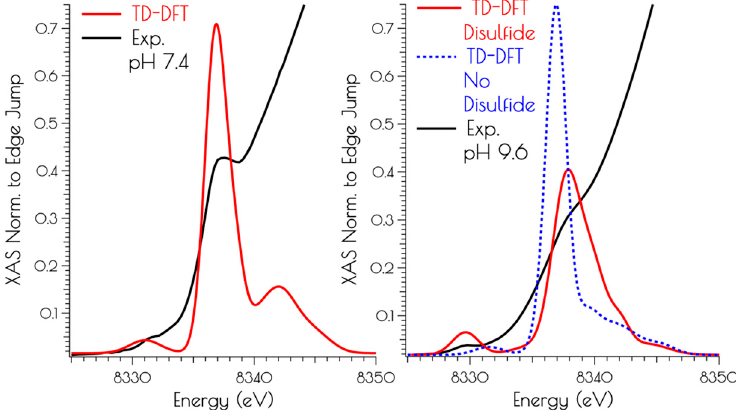
Figure 6. Comparison of the TD-DFT calculated Ni K-edge XANES with the experimental spectra for {Ni 2 (SOD mds )} at pH 7.4 (left) and 9.6